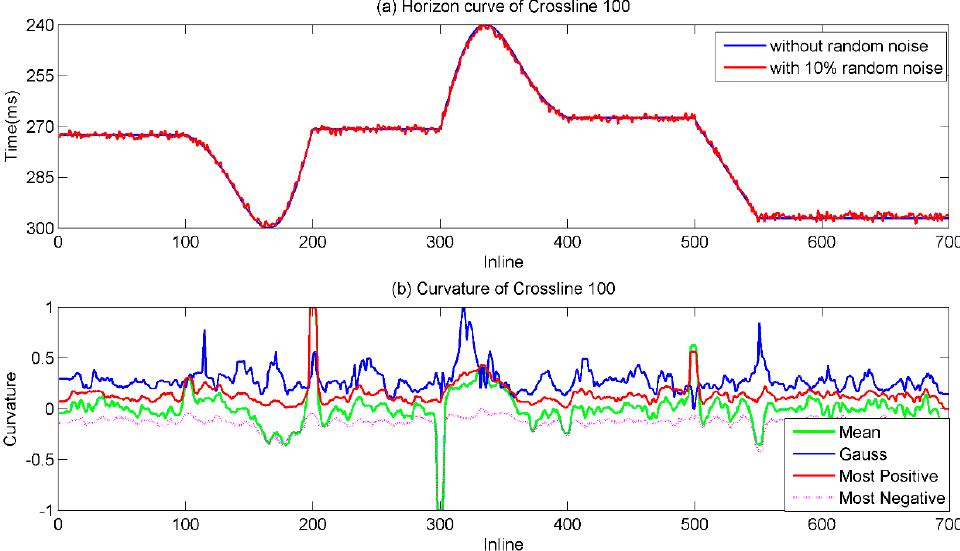
Figure 12. Horizon curve and curvature attributes with 10% noise: ( a ) Horizon curve and ( b ) curvature